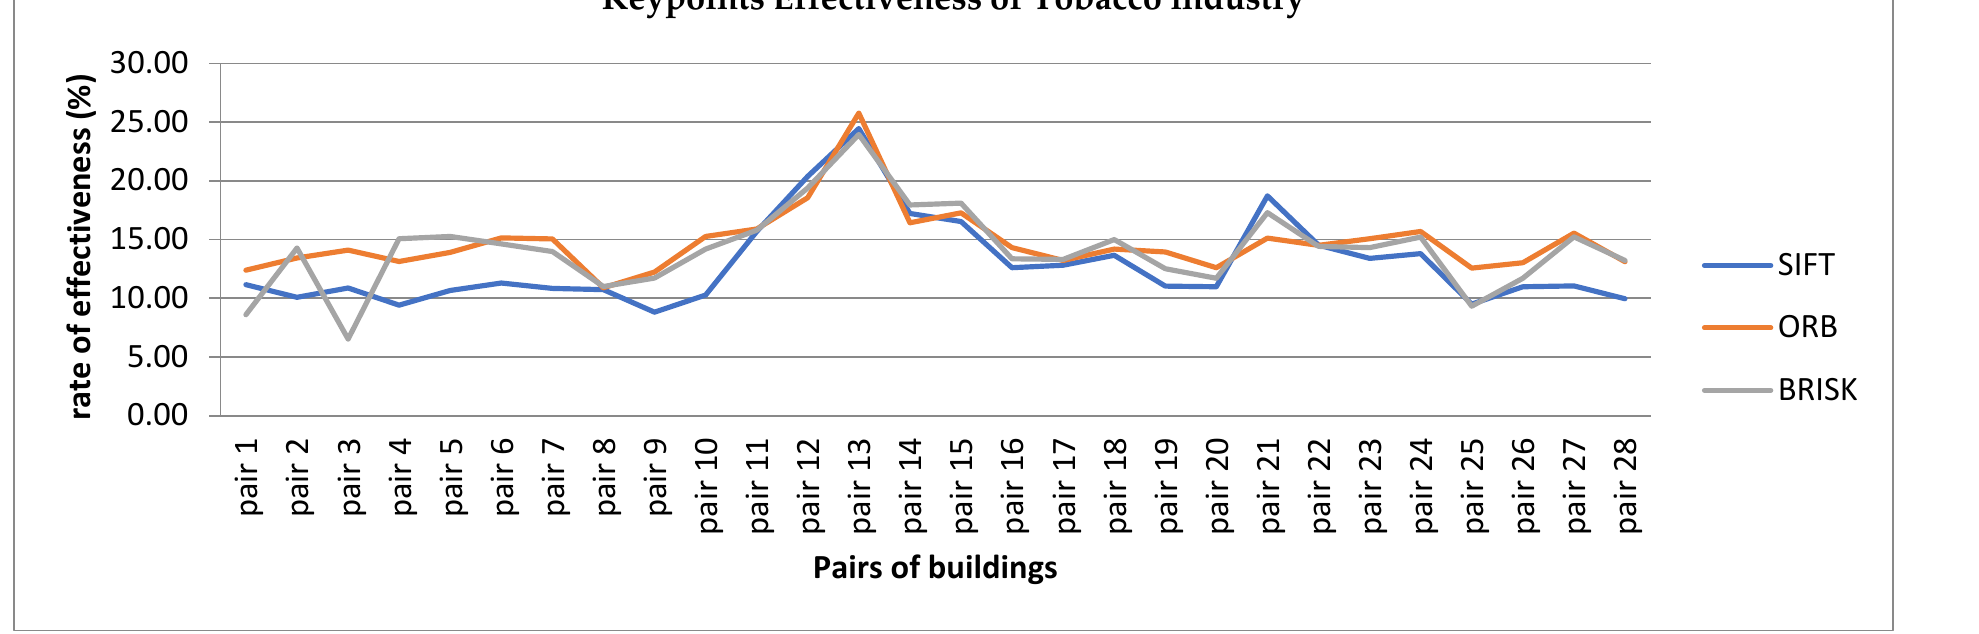
Figure 20. Effectiveness of keypoint matching in pairs of the same building over time.